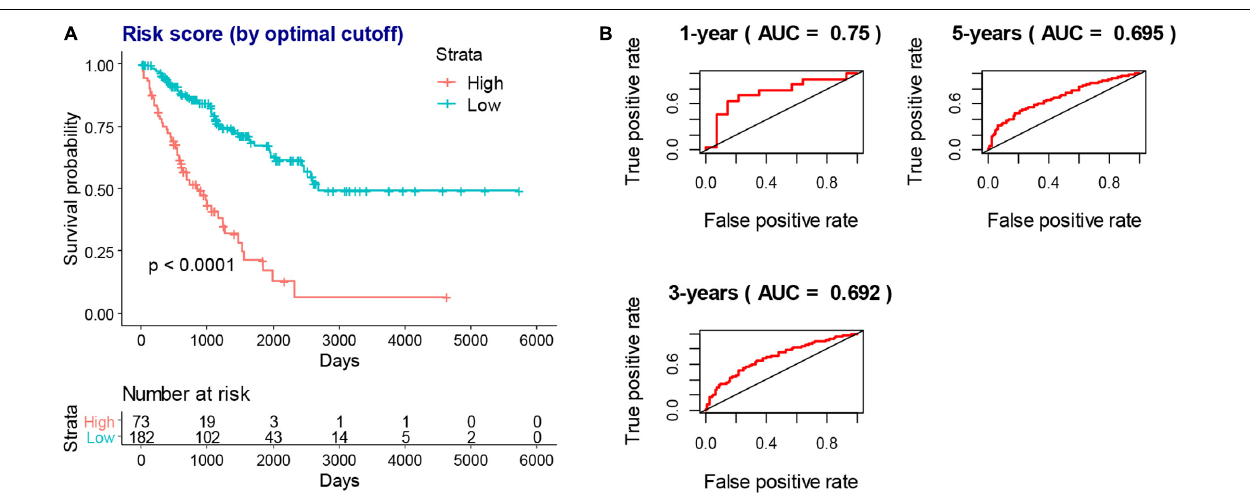
FIGURE 8 | The prognostic value of risk score model. (A) The higher risk scores indicated worse overall survival of SARC patients in KM models which stratified by best cutoff value. (B) The AUC plots of risk scores to predict the 1-year, 3-year, and 5-year overall survival of SARC patients.